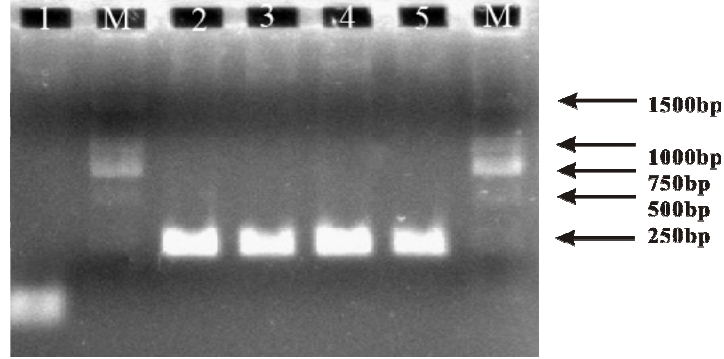
Figure 4. Electrophoretic analysis of the PCR amplicons for the uidA gene of E. coli . The box indicates the 250-bp product ( uidA ). 1, Negative control (NC); M, DNA size marker; 2, wild type uidA gene; 3, mutant type uidA gene; 4 mixed sample with 10% wild type uidA gene; 5, mixed sample with 50% wild type uidA